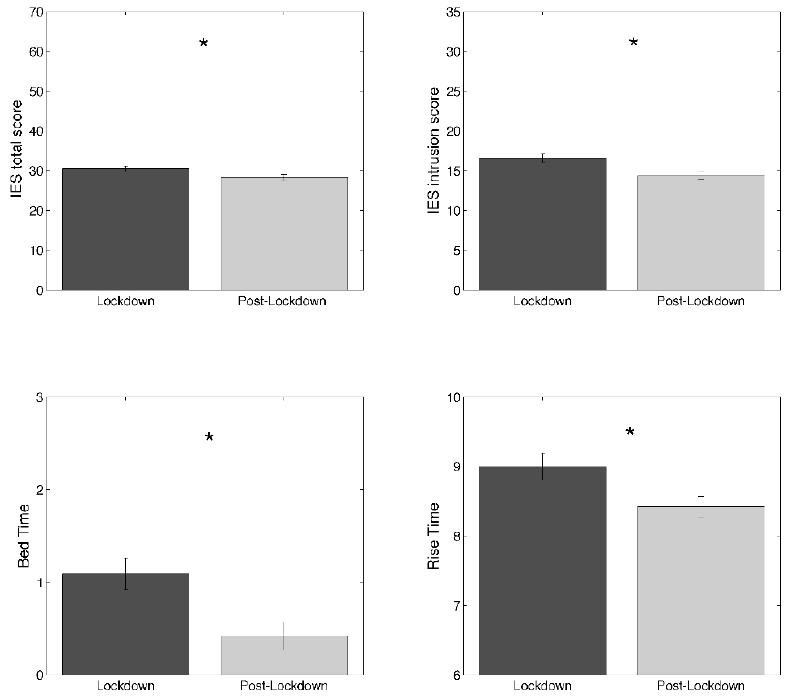
Figure 3. Clinical and sleep variables showing significant results (asterisked; p < 0.05) of the lockdown vs. post-lockdown comparisons (univariate ANOVAs): Impact of Event Scale (IES) total score; IES intrusion score; bedtime; rise time.